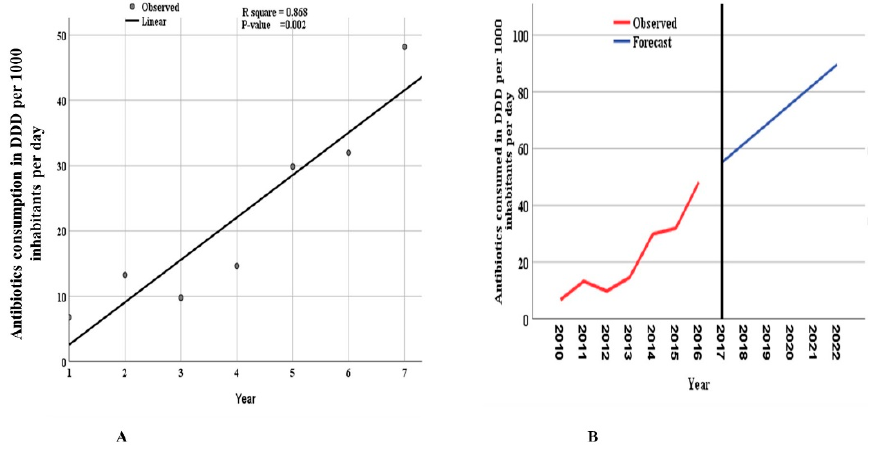
Figure 5. Trends of total consumed antibiotics over seven years from 2010 to 2016. Year 1 corresponds to 2010, and year 7 corresponds to 2016. The linear curve estimation for ( A ) overall consumption of antibiotics shows an increasing trend. ( B ) The autoregressive integrated moving average (ARIMA, 0, 1, 0) model forecasts utilization between 2010 and 2022.